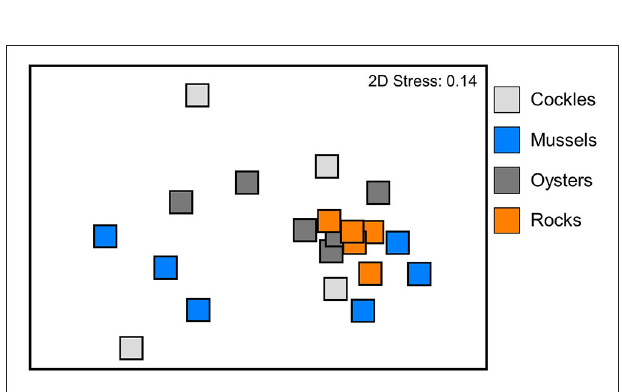
FIGURE 4 | Non-metric multi-dimensional scaling (MDS) of benthic communities within experimental reef units consisting of cockle, mussel and oyster shells as well as rocks. Ordination based on Bray Curtis similarities of square-root transformed abundances of macrobenthic species per reef